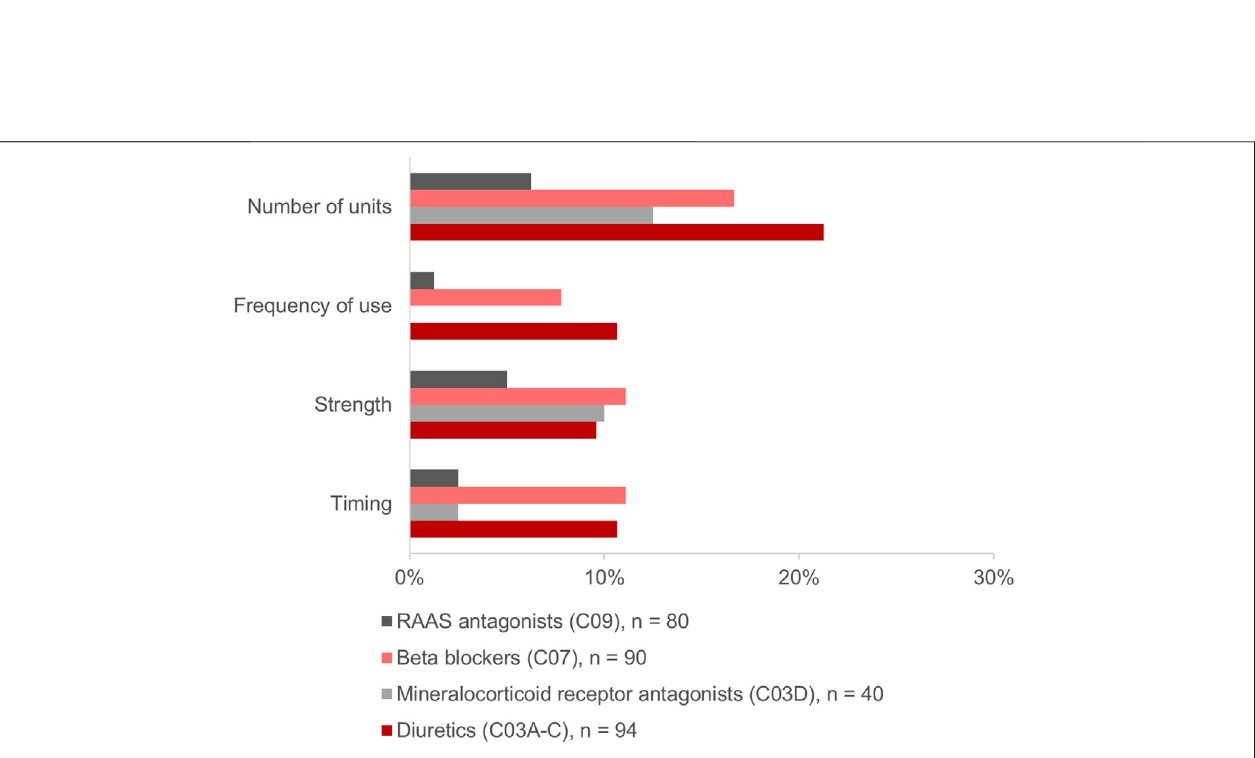
FIGURE 5 | Modi fi cations in the heart failure medication comparing the physician ’ s medication plan (MP) and the consolidated medication plan (CMP).